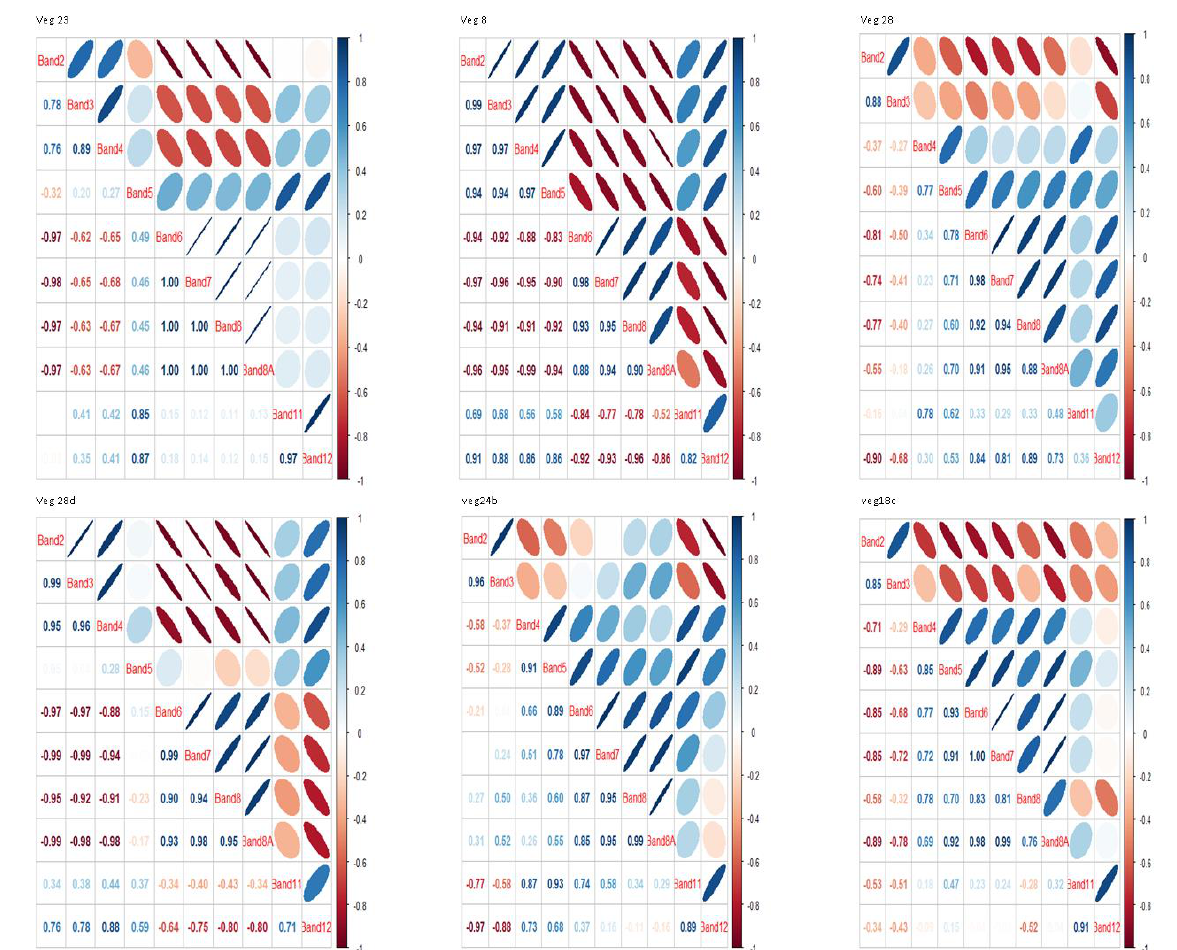
Figure 4. Band correlations of training ROIs. Bands 6, 7 and 8 showed very strong correlation between each other across all the ROIs selected for classification of the vegetation classes. Band 11 is lowly correlated to the rest of the bands in all the ROI classes except for veg24b, while band 8A and 8 are consistently very strongly correlated across all classes. Bands 3 and 4 varied in correlation strengths across the different ROI classes.